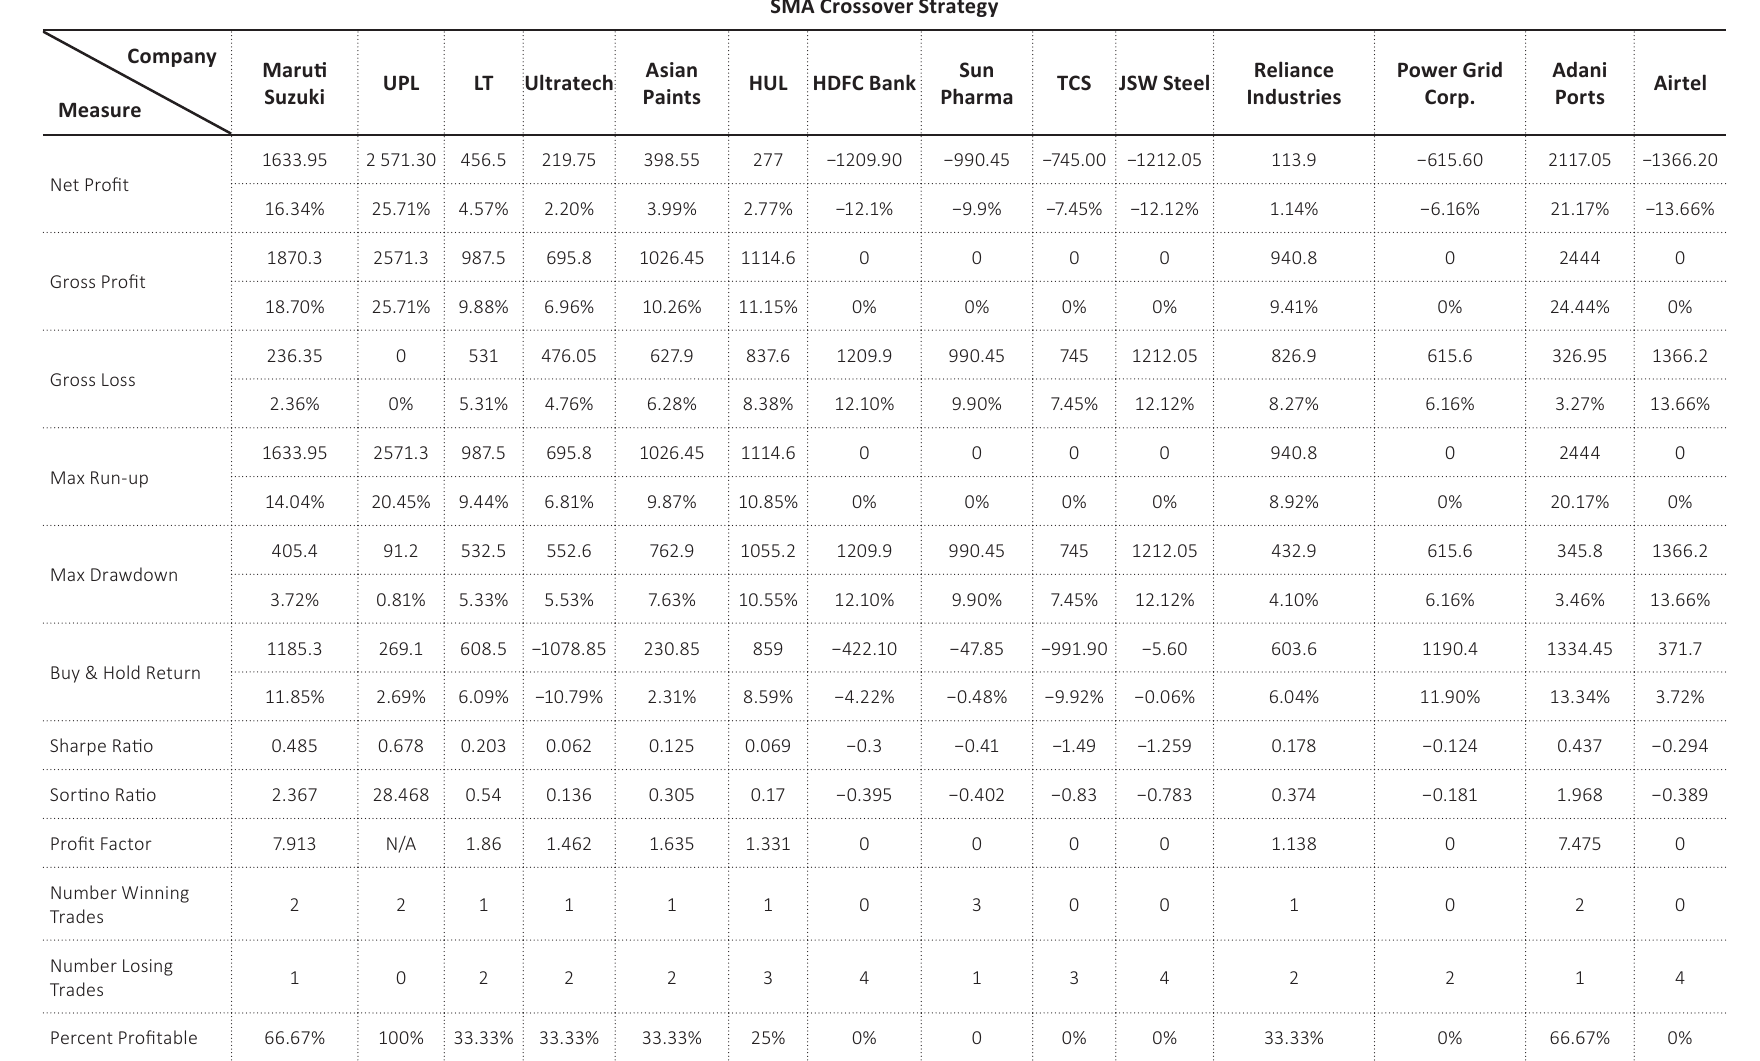
Table A2. SMA Crossover Strategy